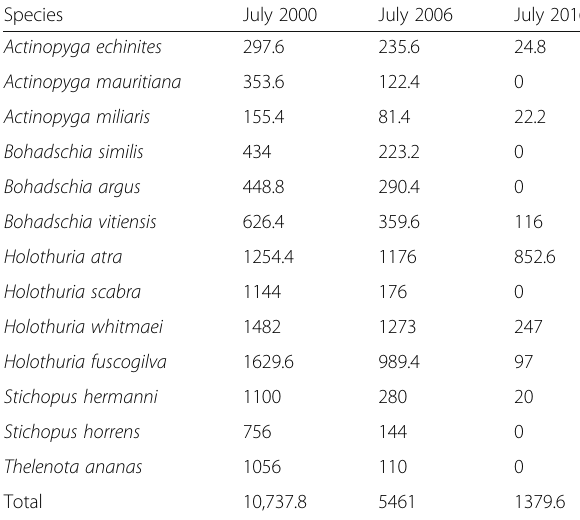
Table 5 Standing stocks (kg) of different sea cucumber species during the period of